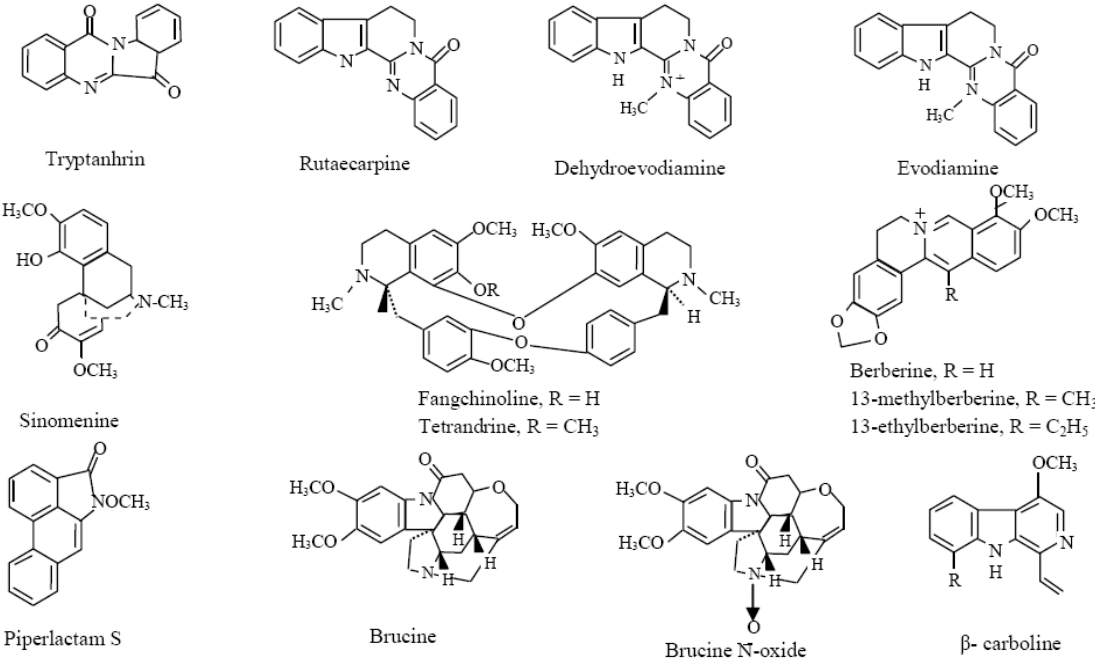
Figure 3. Chemical structures of alkaloids. Adapted from Gautam and Jachak [7].